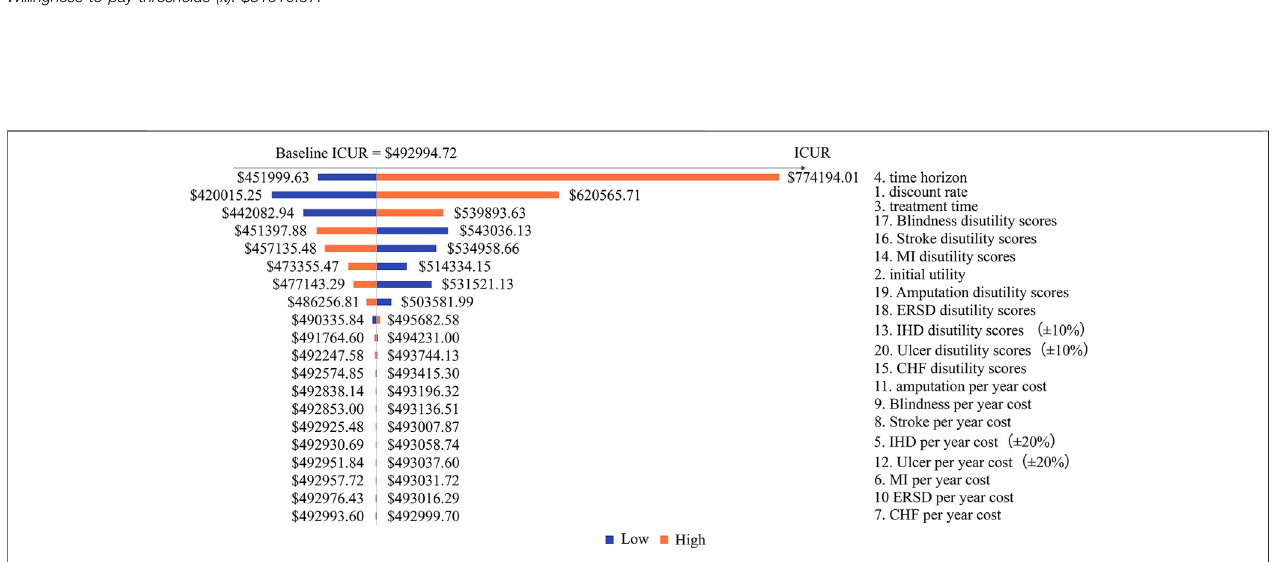
FIGURE 1 | Tornado diagram of the one-way sensitivity analysis (SEMA group vs. DULA